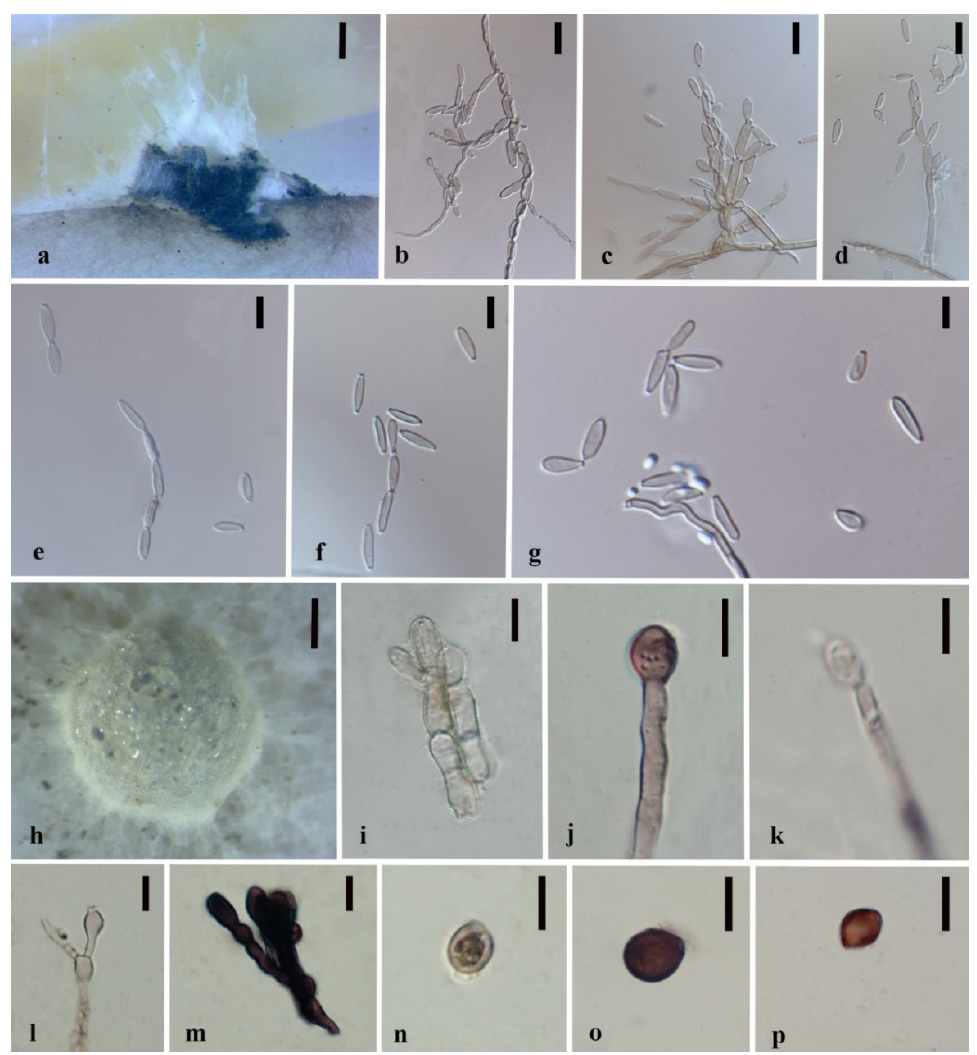
Figure 17. Xylaria berteri . ( a ) Conidiomata. ( b – d ) Conidiophores with conidia. ( e – g ) Conidia. ( h ) Conidiomata. ( i – m ) Conidiophore-like structures. ( n – p ) Conidia-like structures. Notes: ( a – g ) on WA, slide culture, ( h – p ) on PDA. Scale bars: ( a ) = 200 μ m, ( b – g ) = 10 μ m, ( h ) = 500 μ m, ( i – p ) = 10 μ m.